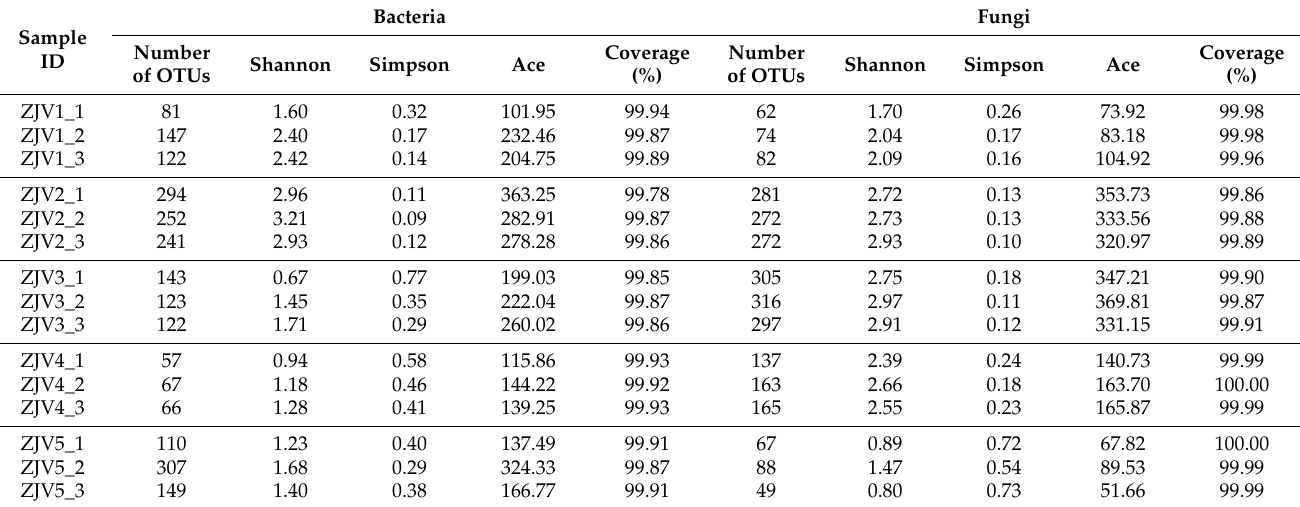
Table 2. Alpha diversity of bacterial and fungal communities in